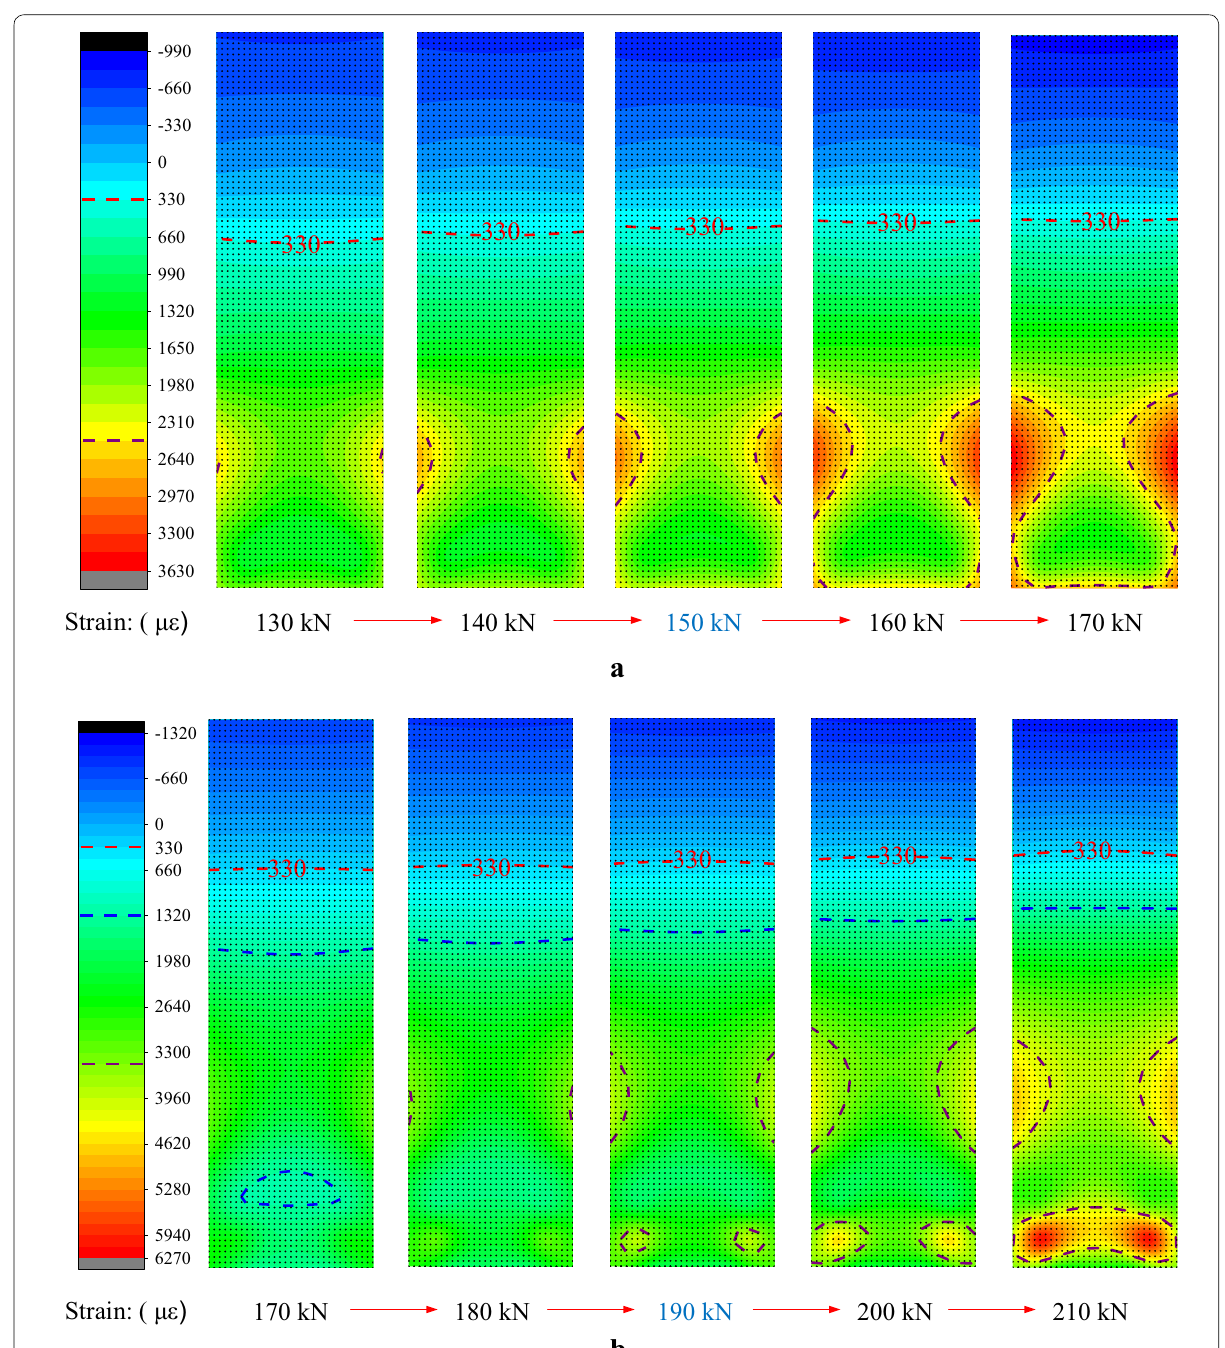
Fig. 14 The strain fields of the RC beams with different concrete strength around characteristic loads Q : a the strain fields of the contrast beam (B1); b the strain fields of CFRP-strengthened beam B2; c the strain fields of CFRP-strengthened beam B3; d the strain fields of CFRP-strengthened beam